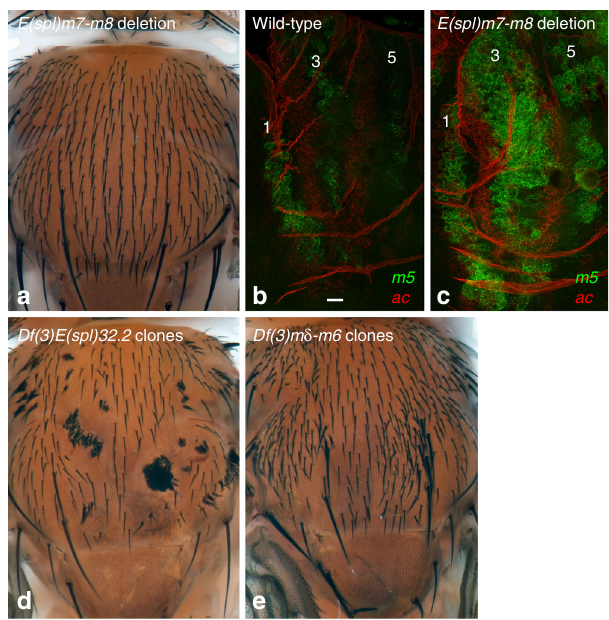
Fig. 8 The m7 and m8 genes contribute to SOP selection. a Dorsal thorax of an E(spl)m7-m8/Df(3)P11 fl y, lacking the m7 and m8 genes and carrying one copy of the m γ -m5 genes. An increase in bristle density ( + 35%) was observed. The m7 and m8 genes are required for the proper spacing of SOPs within a stripe but are dispensable for stripe patterning. b , c The expression of the m5 gene (smiFISH probe, green) was signi fi cantly upregulated in proneural stripes 1,3 and 5, at 8 h apf, in E(spl)m7-m8 mutant pupae ( c ) relative to wild-type controls ( b ; ac probe, red). d , e Adult fl ies with clones of cells homozygous for the E(spl)32 .2 deletion, i.e., lacking all E (spl)-C genes, show patches of tufted bristles ( d ), whereas clones of Df(3L) m δ -m6 mutant cells display increased bristle density ( e ). This indicates that the m7 and m8 genes are suf fi cient for the singling out of SOPs. Scale bar